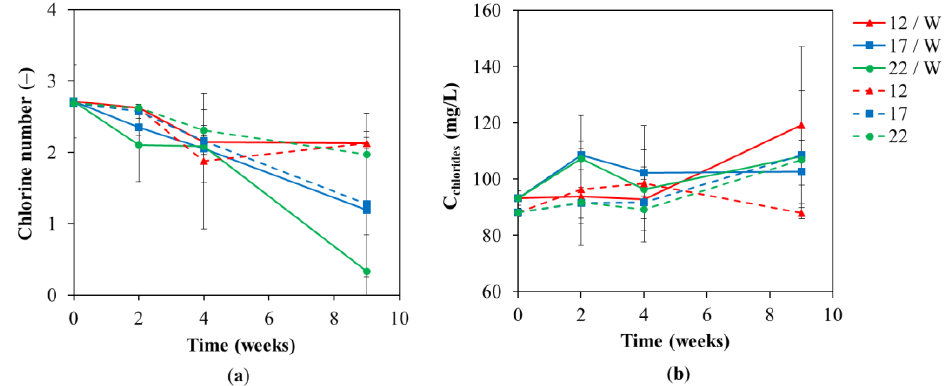
Figure 5. ( a ) Chlorine number and ( b ) chlorides concentration in the groundwater at different lab test temperatures of 12 °C, 17 °C, and 22 °C during the lab-scale test with and without whey addition.